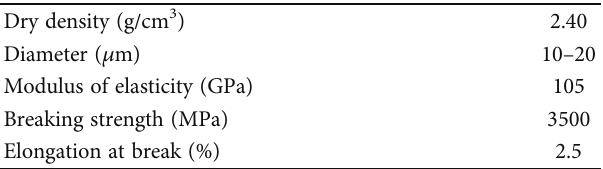
Table 1: Physical properties of the basalt fi ber.